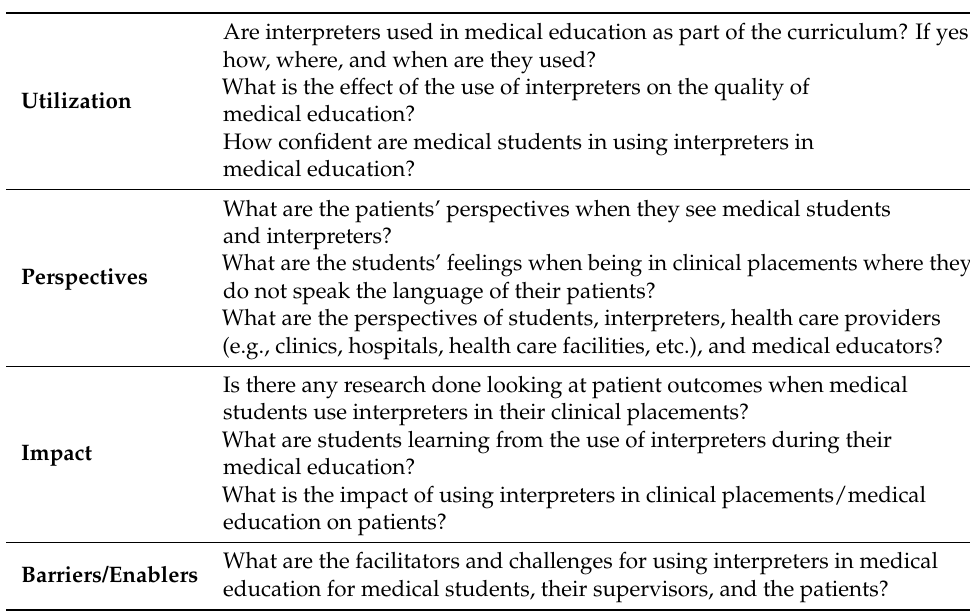
Table 2. Organization of search